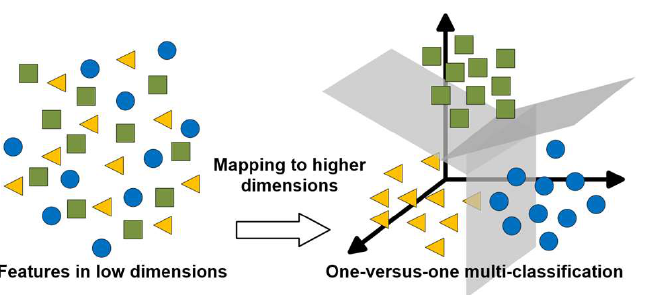
Figure 5. Multi-classification diagram.